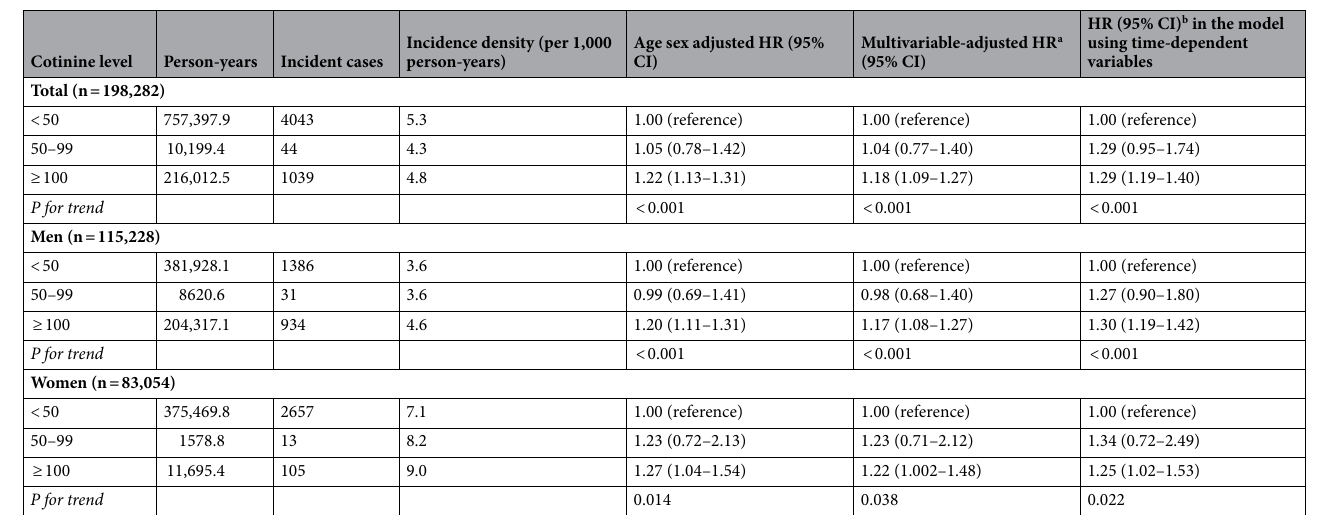
Table 4. Development of bilateral visual impairment according to cotinine level. The P value for the interaction of sex and cotinine levels for risk of bilateral visual impairment was 0.742. BMI body mass index, CI confidence intervals, CVD cardiovascular disease, HR hazards ratio. a Estimated from parametric proportional hazard models. Multivariable model was adjusted for age, sex (only for total), center, year of screening exam, BMI, physical activity, alcohol intake, total energy intake, educational level, medication for dyslipidemia, history of CVD, history of diabetes, and history of hypertension. b Estimated from parametric proportional hazard models with cotinine levels category, physical activity, alcohol intake, total energy intake, BMI, medication for dyslipidemia, history of diabetes, history of hypertension, and history of CVD as time- dependent categorical variables and baseline age, sex, center, year of screening exam, and education level as time-fixed